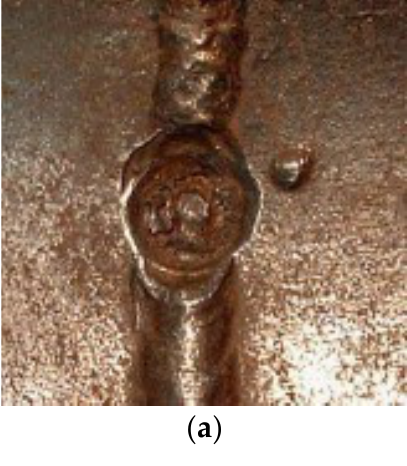
Figure 4. Burn-through defects ( a ) in a plate, adapted from [12], and ( b ) identified in an X-ray test of a weld bead, adapted from [4].